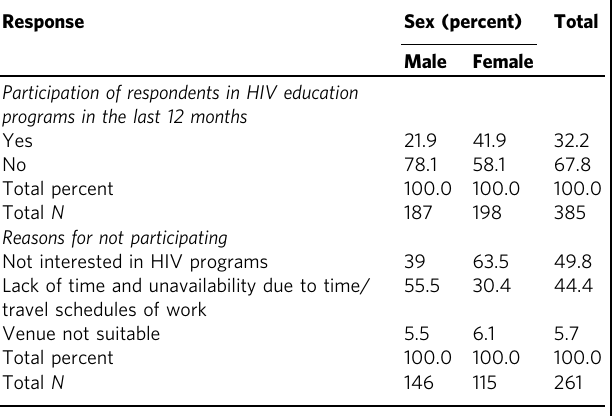
Table 4 Participation of respondents in HIV Education and reasons for not